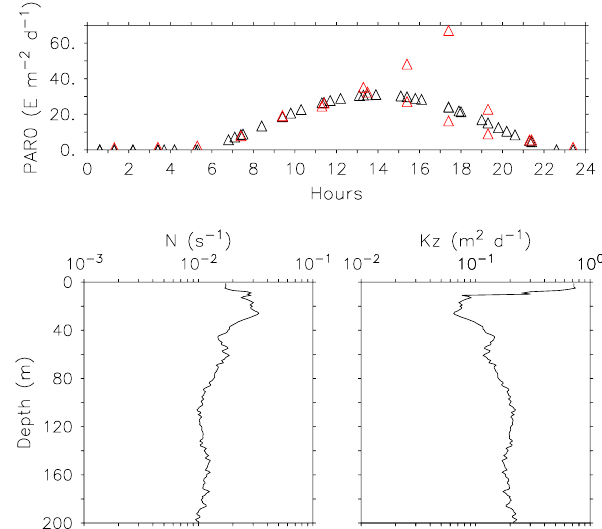
from-data (black triangles) surface PAR (PAR0, upper panel), 4-day (14–16 August, 2009) averaged profile of measured Brunt-V¨ais¨al¨a frequency ( N , lower left panel) and derived profile of eddy diffusion coefficient ( K z , lower right